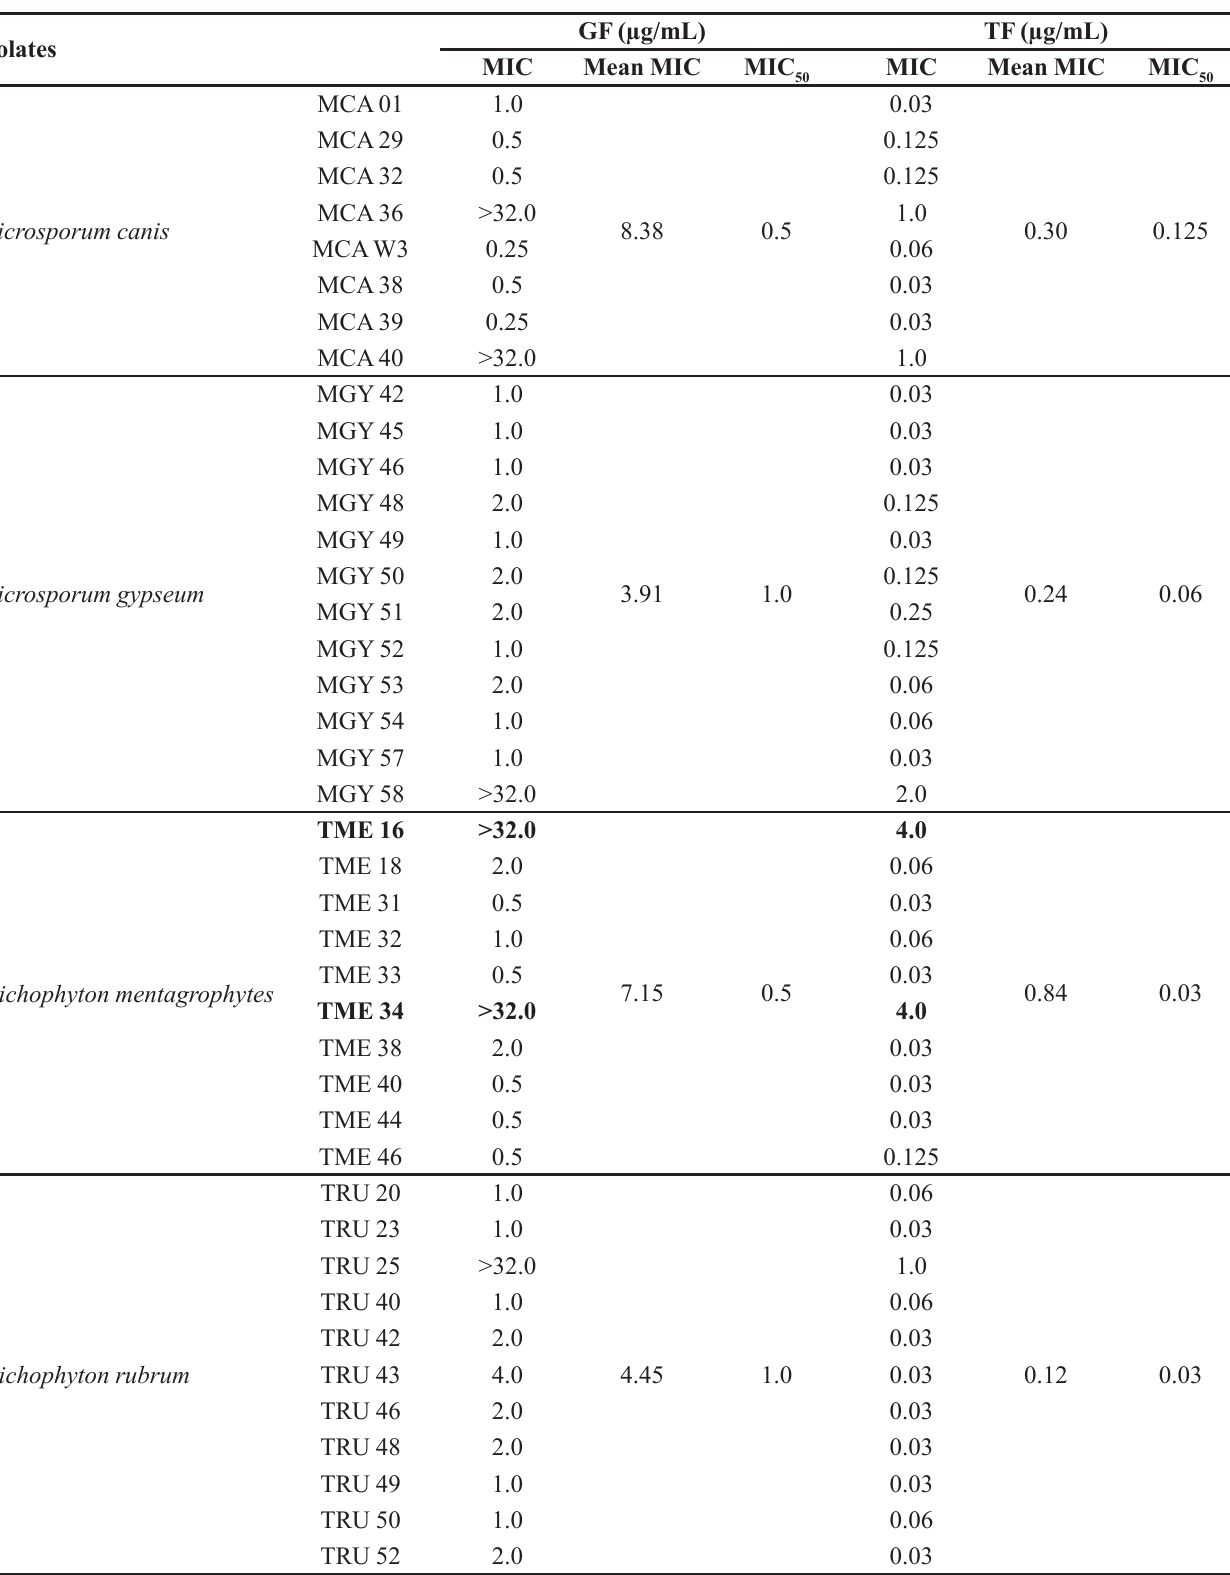
TABLE I - MICs to GF and TF against dermatophyte isolates